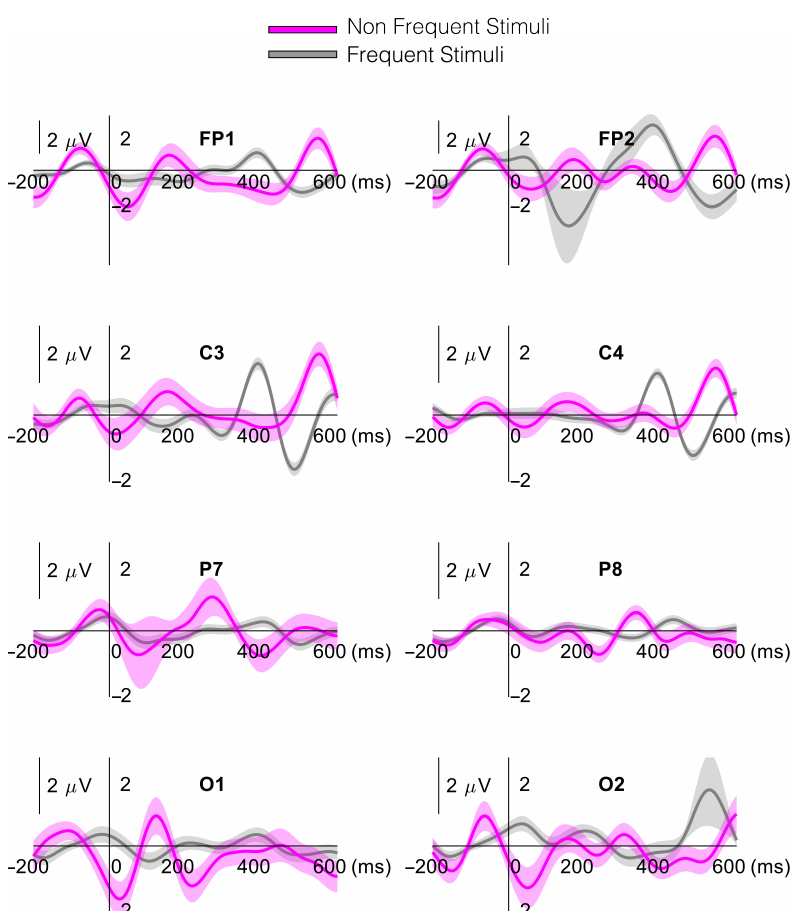
Figure 4. Grand average representation of the P300 wave across all participants. Eight traces (one per channel) are presented for frontal (F), central (C), parietal (P) and occipital (O) electrodes of the left and right hemispheres of the brain. Shaded area represents standard error across